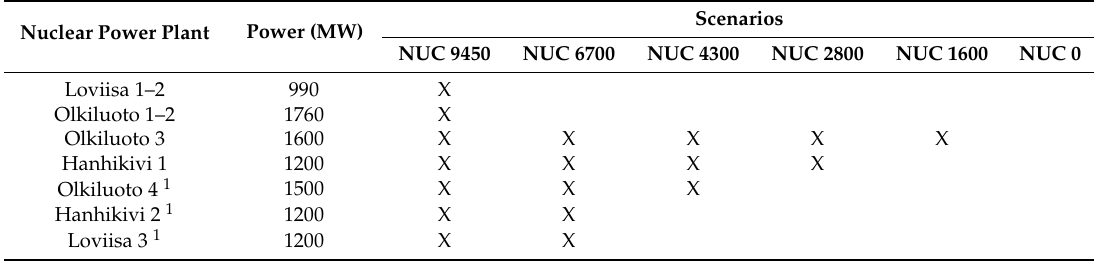
Table 1. Nuclear power scenarios in the national case for 2050. “X” denotes inclusion in the scenario. Scenarios Nuclear Power Plant Power (MW) NUC